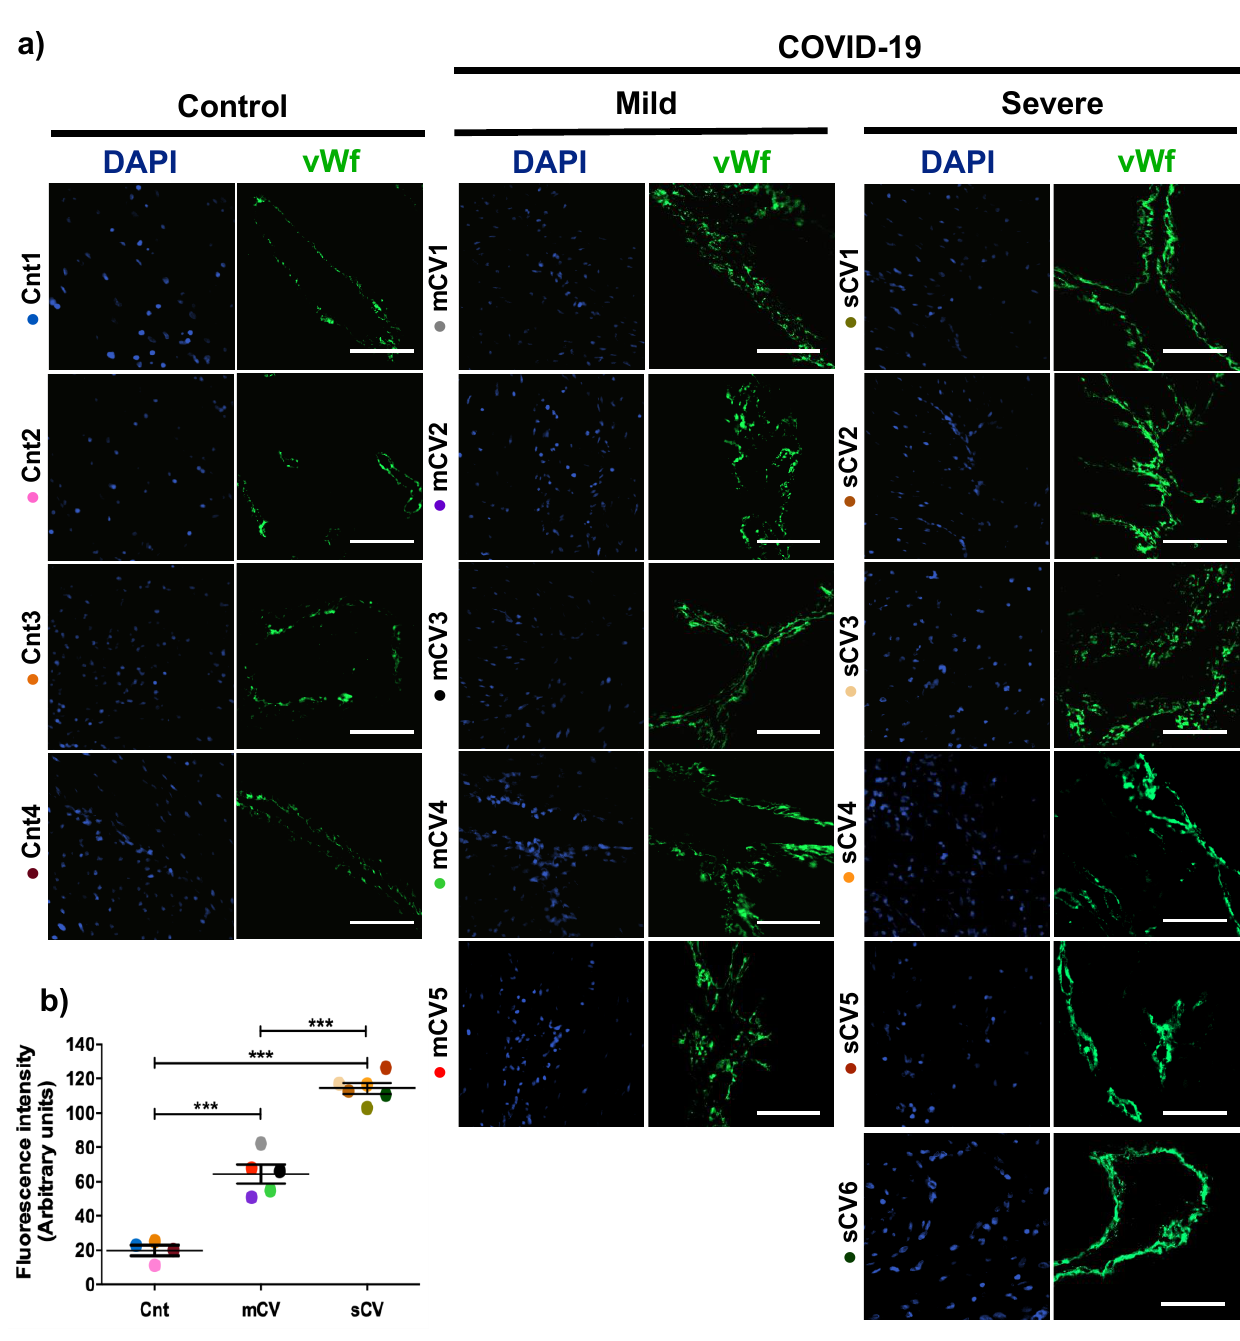
Figure 1. The expression of vWf augments in decidual endothelium of placentas of women with COVID-19. Paraffin blocks of placenta from women with COVID-19 and controls were cut in 1 µ m slices, deparaffinized and processed for immunofluorescence with antibodies against vWf. ( a ) Representative images of vWf in decidua. DNA of nuclei was stained with DAPI. Bar, 100 µ m. ( b ) Quantification of mean fluorescent intensity done on three independent images from each condition. Data are expressed as mean ± SD; F ANOVA test followed by Duncan’s multiple comparison test, *** p < 0.001. Cnt, control; mCV, mild COVID-19; sCV, severe COVID-19.